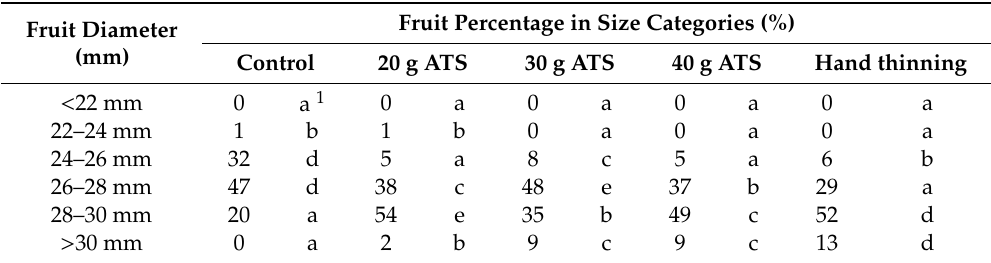
Table 8. The e ff ect of thinning on the percentage of size categories of ‘Regina’ sweet cherry fruit (based on fruit diameter) in 2012. Fruit